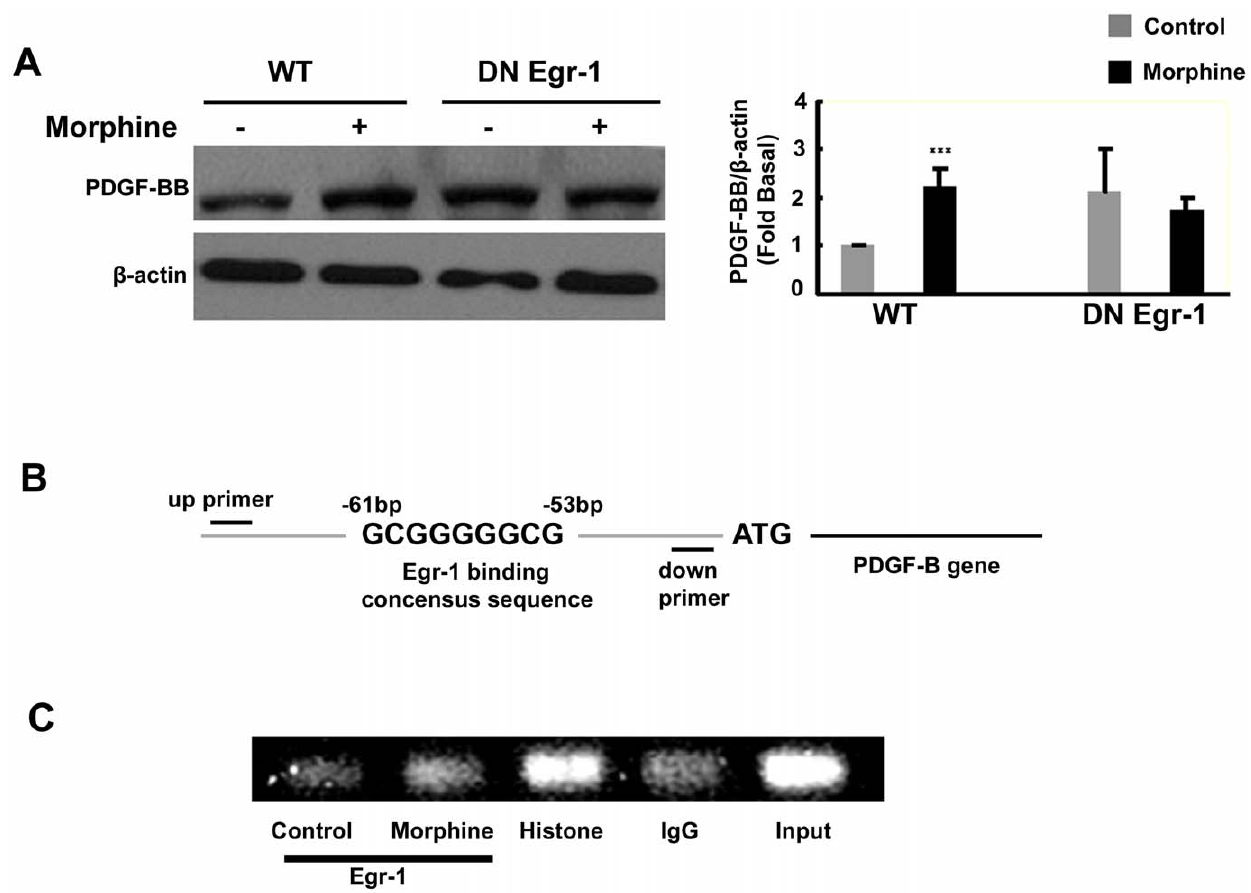
Figure 4. Involvement of Egr-1 in morphine-mediated induction of PDGF-BB in HBMECs. ( A ) Whole cell lysates of HBMECs transfected with either the wild type (WT) or dominant negative (DN) construct of Egr-1 were subject to western blot analysis using antibodies specific for PDGF- BB. Transfection of cells with the DN-Egr-1, but not the WT-Egr-1 inhibited morphine-mediated induction of PDGF-BB expression. ( B ) Schematic illustration of Egr-1 binding consensus sequence on the PDGF-B promoter region. ( C ) ChIP assay demonstrating morphine-mediated binding of Egr-1 to the PDGF-B promoter. All the data are presented as mean 6 SD of three individual experiments. ***p , 0.001 vs control group.